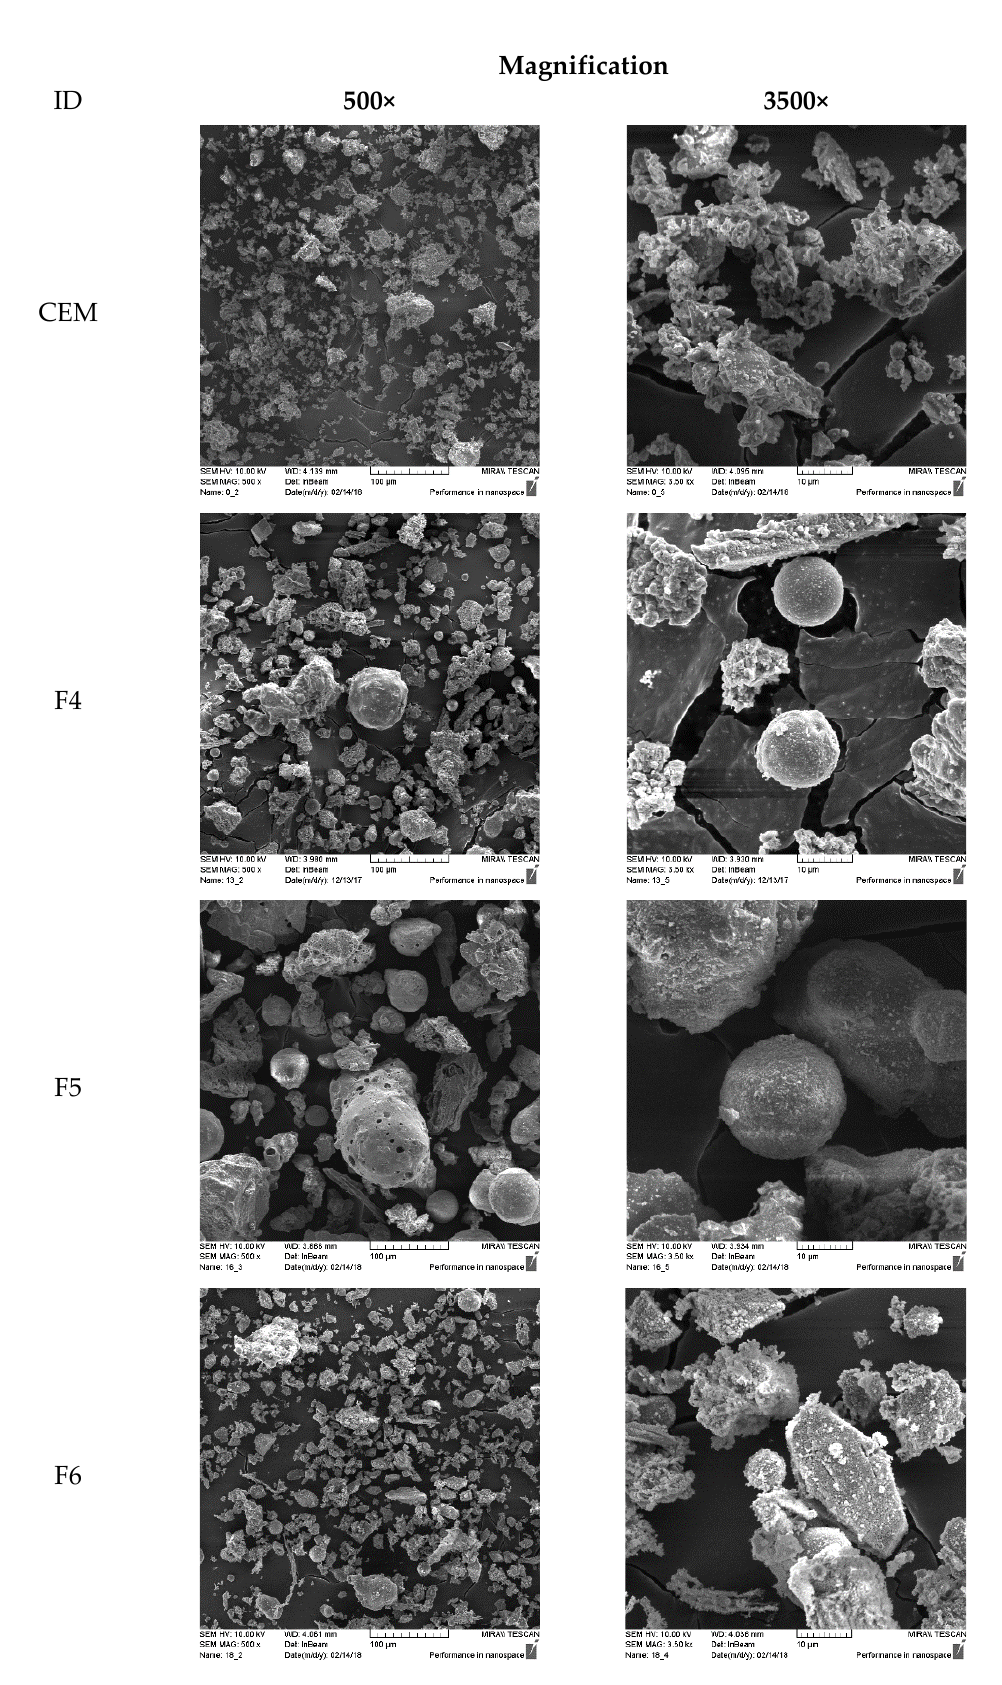
Figure 4. SEM images at 500 × and 3500 × magnification of cement and WFA.